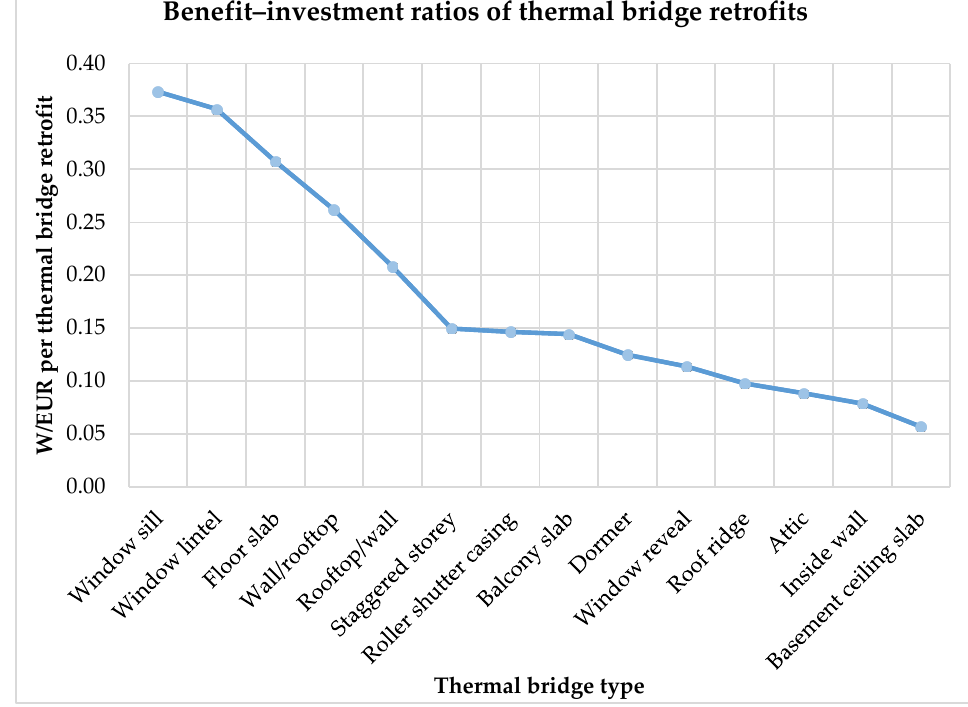
Figure 6. Benefit–cost ratios for energy savings of the retrofits of 14 thermal bridge types of German buildings constructed between 1950 and